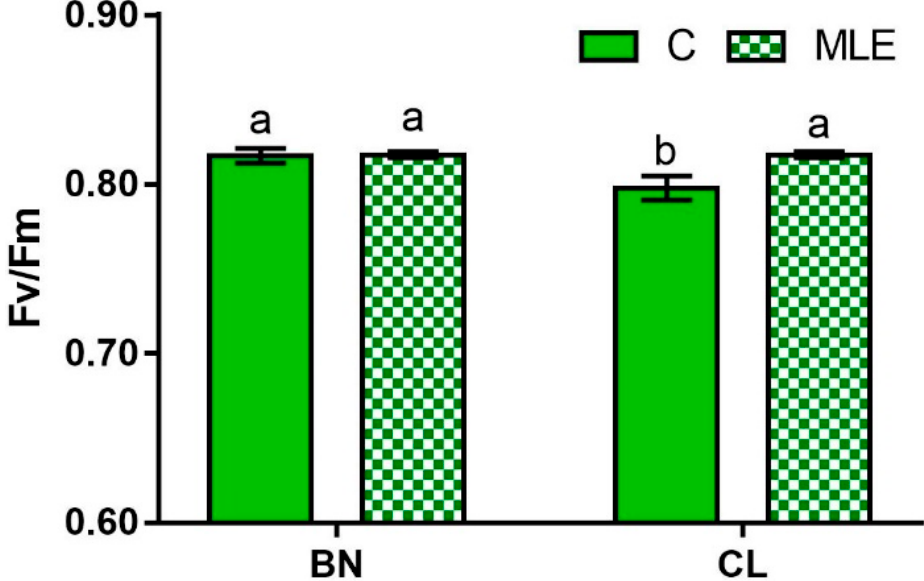
Figure 1. Effect of interaction of maximum quantum efficiency of photosystem II (Fv/Fm) from leaves of BN and CL treated with distilled water (C) and moringa leaf extract (MLE). Values are the means ± standard error (SE, n = 9). Different letters: statistically significantly different means for p < 0.05 (LSD test).